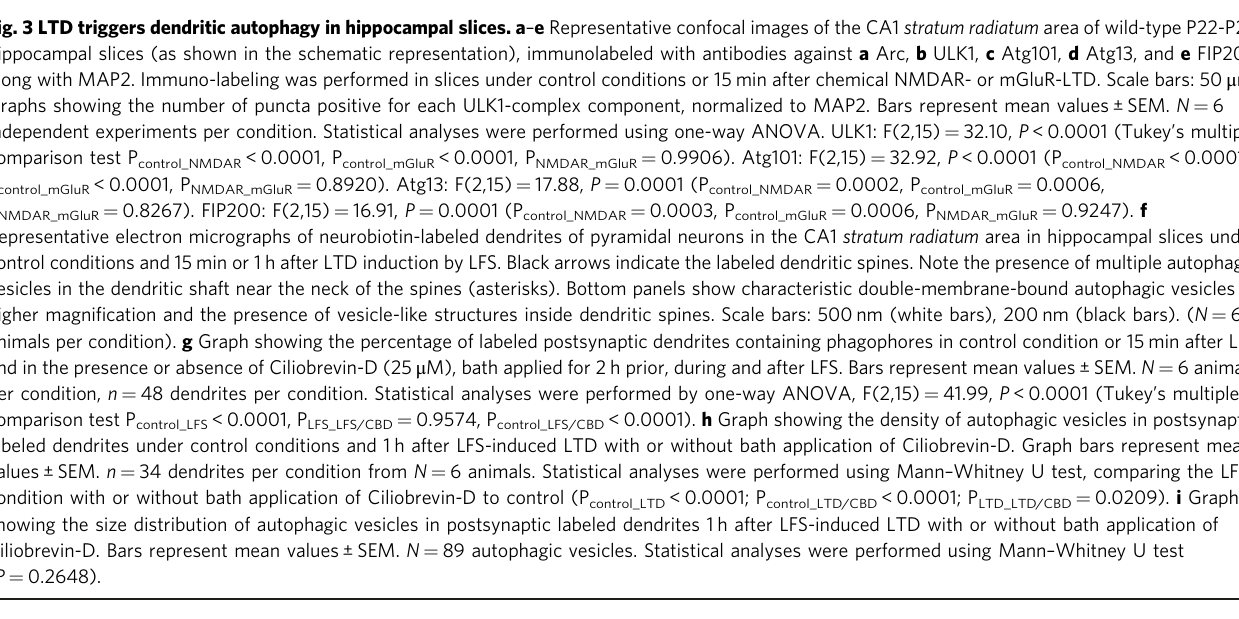
Fig. 3 LTD triggers dendritic autophagy in hippocampal slices. a – e Representative confocal images of the CA1 stratum radiatum area of wild-type P22-P28 hippocampal slices (as shown in the schematic representation), immunolabeled with antibodies against a Arc, b ULK1, c Atg101, d Atg13, and e FIP200 along with MAP2. Immuno-labeling was performed in slices under control conditions or 15 min after chemical NMDAR- or mGluR-LTD. Scale bars: 50 μ m. Graphs showing the number of puncta positive for each ULK1-complex component, normalized to MAP2. Bars represent mean values ± SEM. N = 6 independent experiments per condition. Statistical analyses were performed using one-way ANOVA. ULK1: F(2,15) = 32.10, P < 0.0001 (Tukey ’ s multiple comparison test P control_NMDAR < 0.0001, P control_mGluR < 0.0001, P NMDAR_mGluR = 0.9906). Atg101: F(2,15) = 32.92, P < 0.0001 (P control_NMDAR < 0.0001, P control_mGluR < 0.0001, P NMDAR_mGluR = 0.8920). Atg13: F(2,15) = 17.88, P = 0.0001 (P control_NMDAR = 0.0002, P control_mGluR =